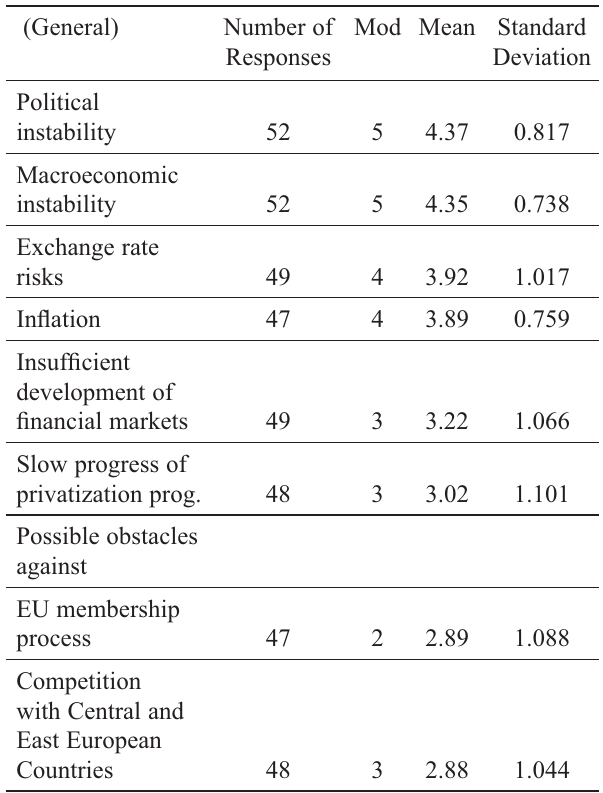
Table 6 . Barriers to Foreign Direct Investment in Turkey